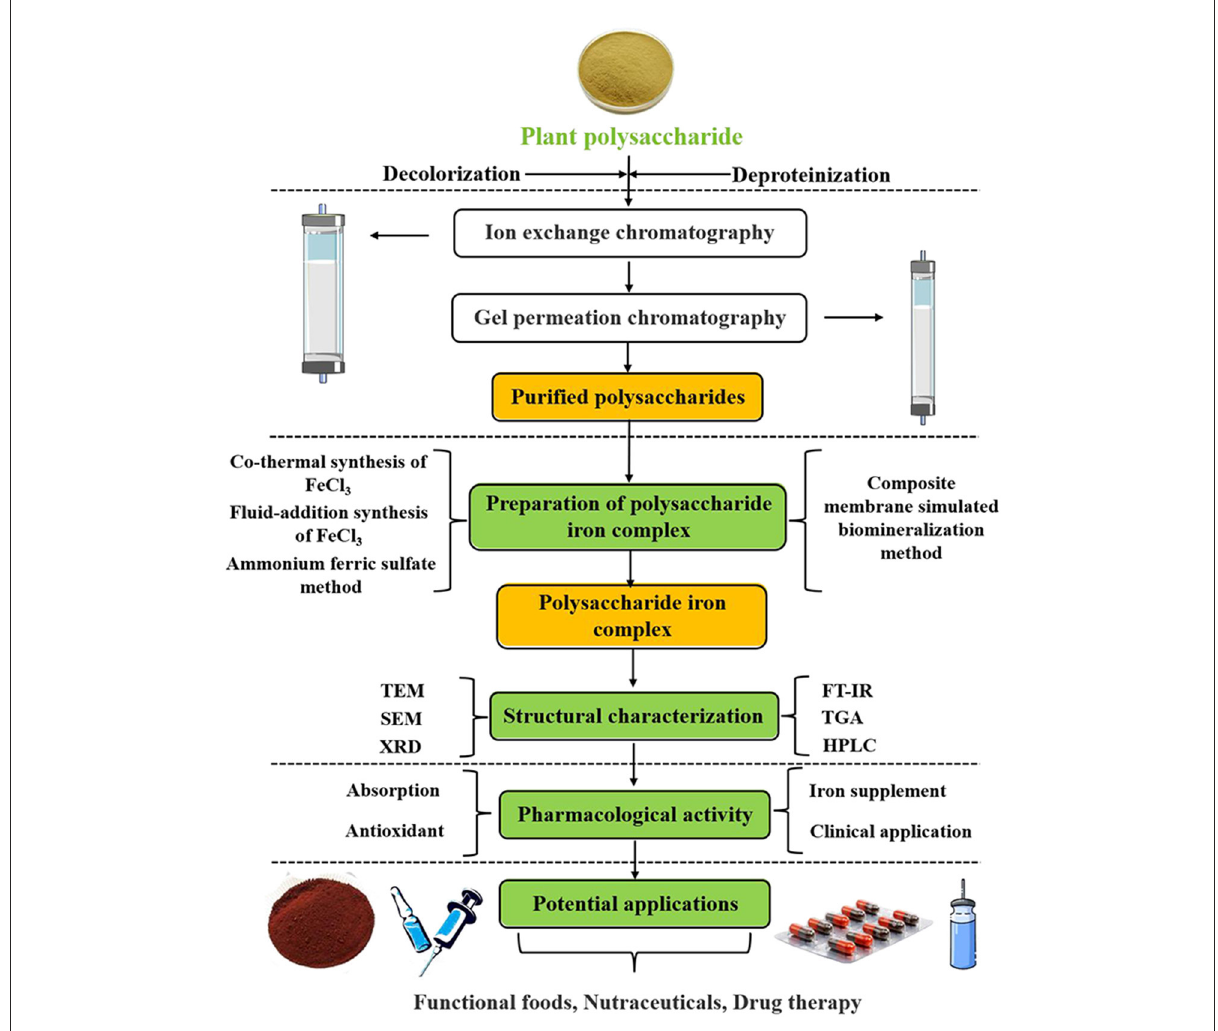
FIGURE1 Overall research idea chart of